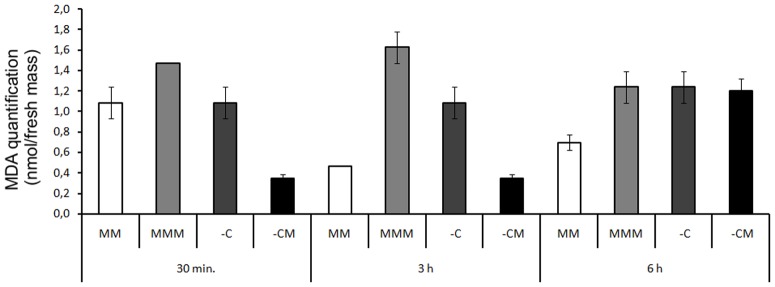
MDA levels in E. coli DH5-α in MM, and in the MMM, -C and -CM treatments, during periods of 30 min., 3 h and 6 h, respectively.LSD = 0.18 for all pairwise comparison.